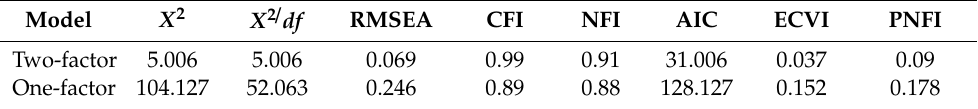
Table 4. Goodness-of-fit indices for the PHQ-4 one-factor and two-factor models.